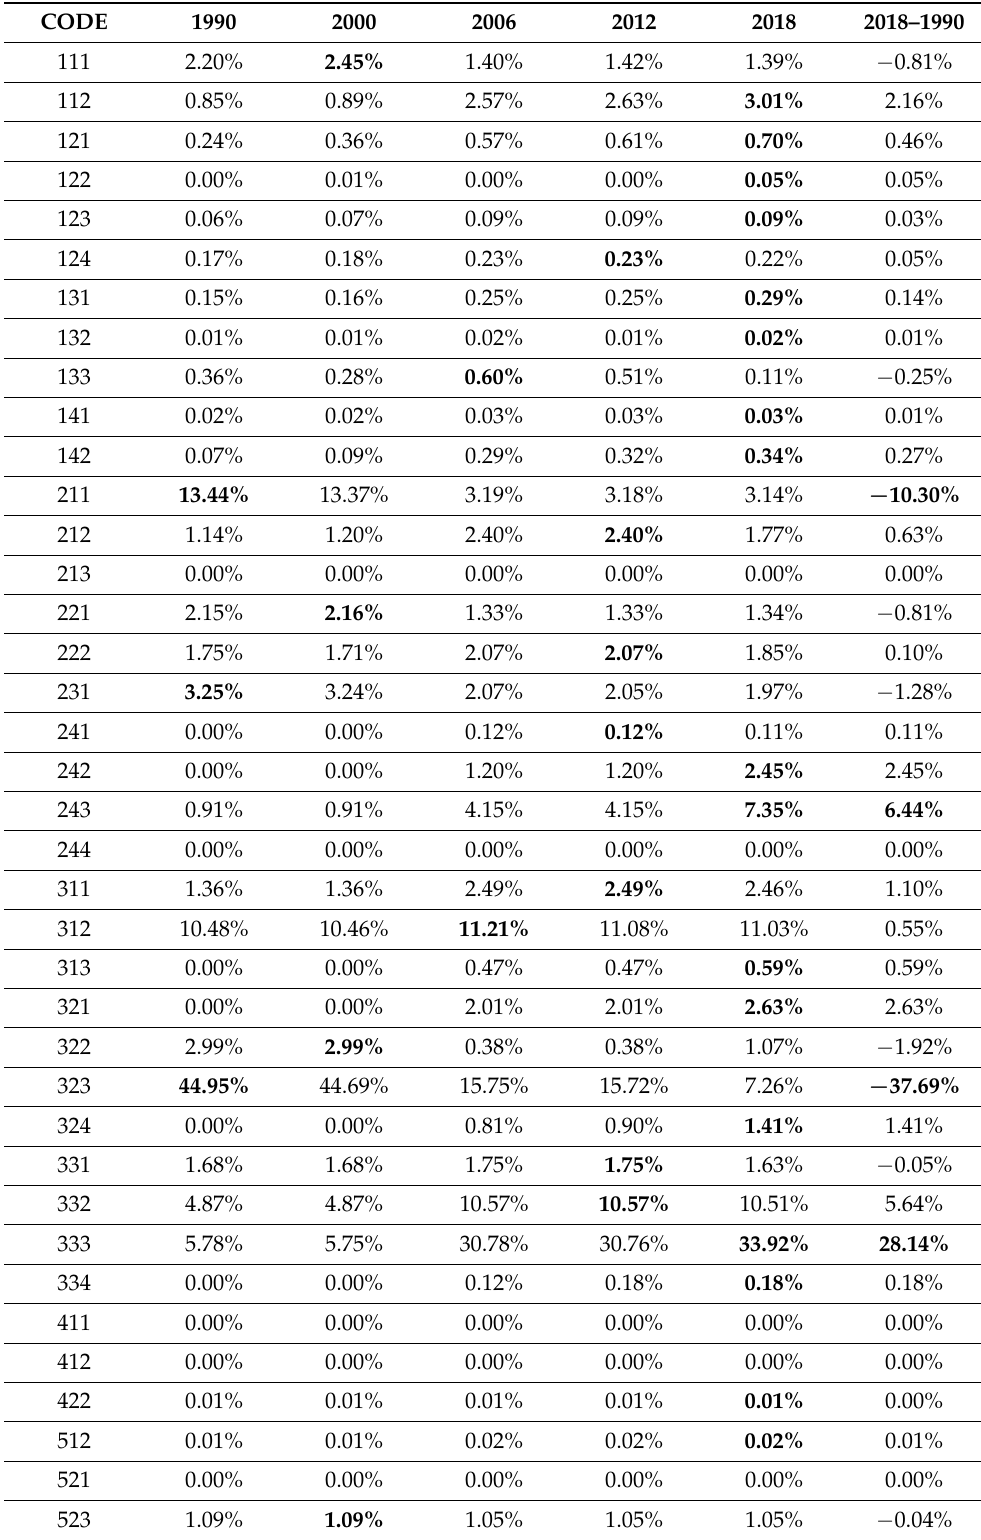
Table 7. Percentage of land-uses according to CLC nomenclature in the Autonomous Community of the Canary